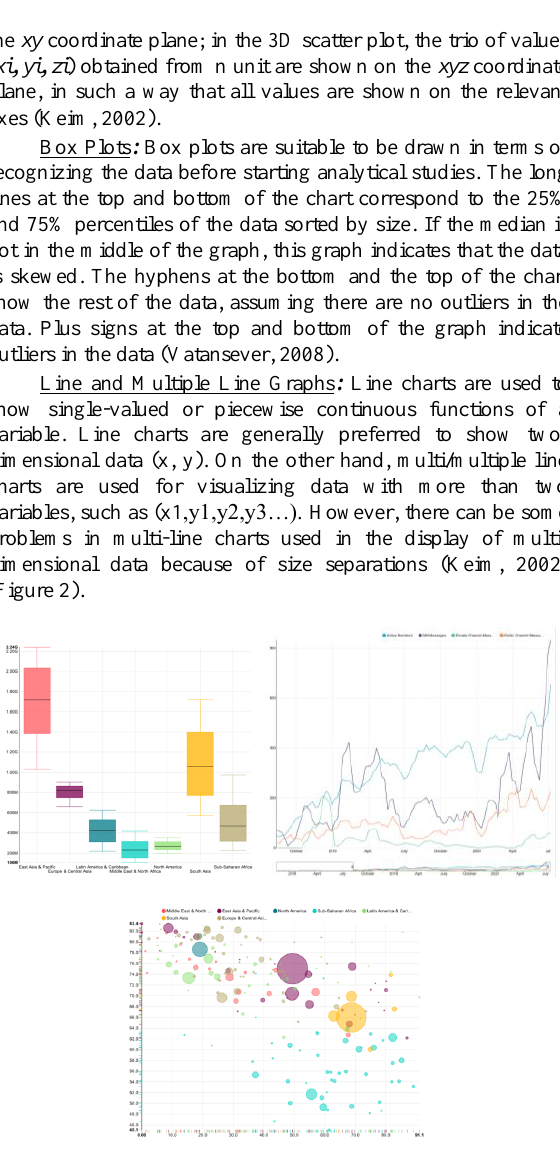
Figure 2. Box Plot (upper-left), Multiple Line (upper-right) and Scatterplot Graphs (bottom) in 2D